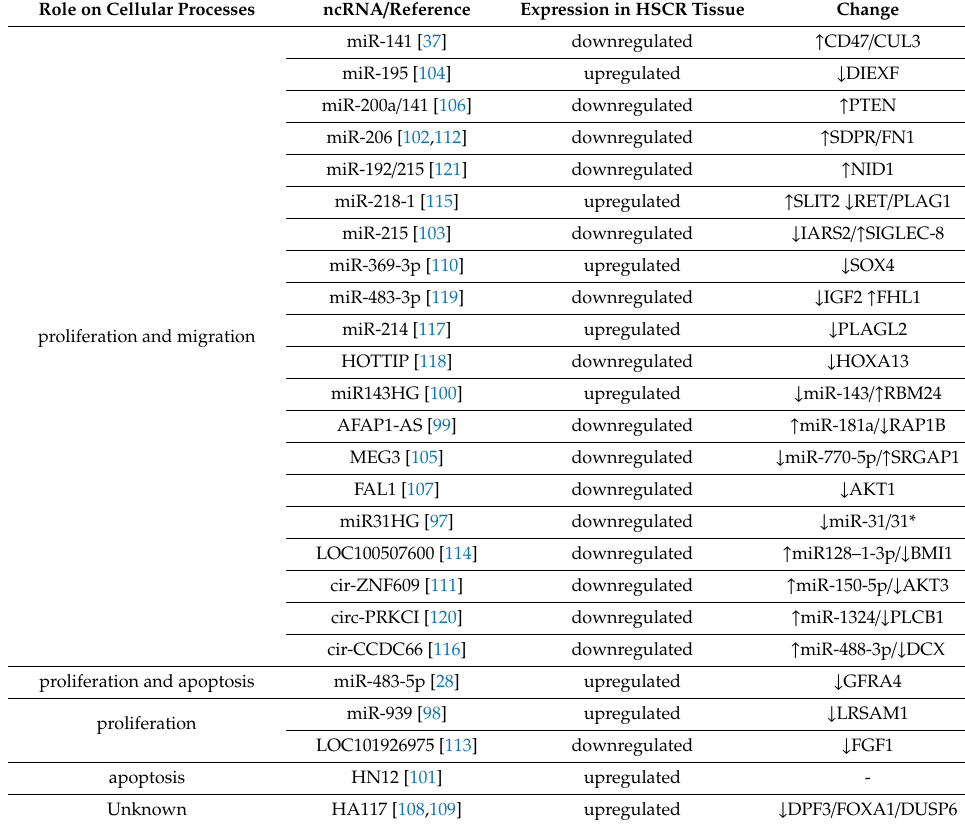
Table 1. NcRNAs with a potential role into the pathogenesis of